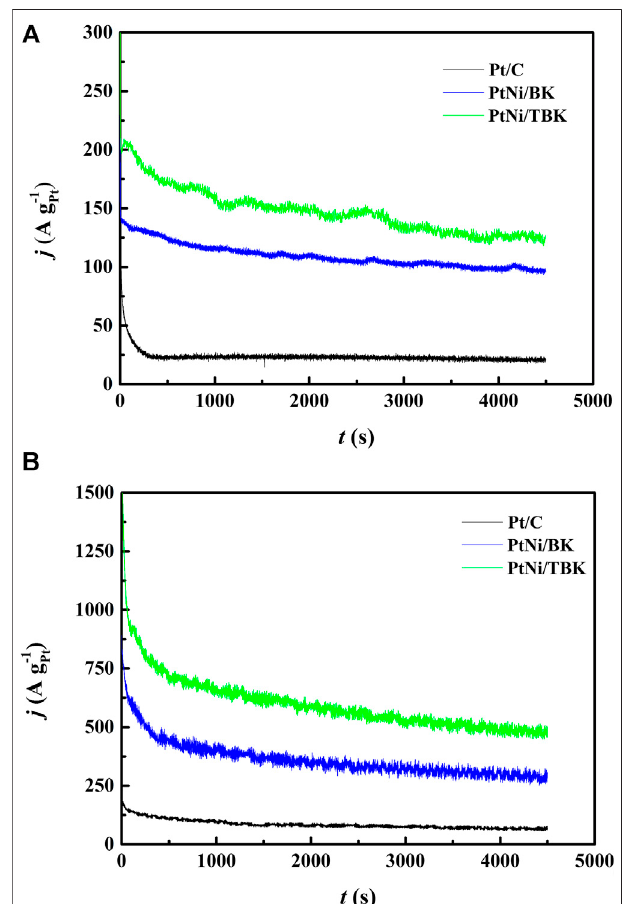
FIGURE 6 | Current-time curves at 0.5 V vs. SCE for Pt/C, PtNi/BK and PtNi/TBK electrodesin a1 M CH 3 CH 2 OH + 0.5 M H 2 SO 4 solution at 25 ° C (A) and 60 ° C (B) .